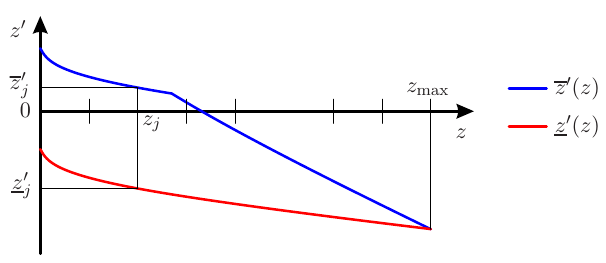
and min j Figure 5. Dynamic programming algorithm.